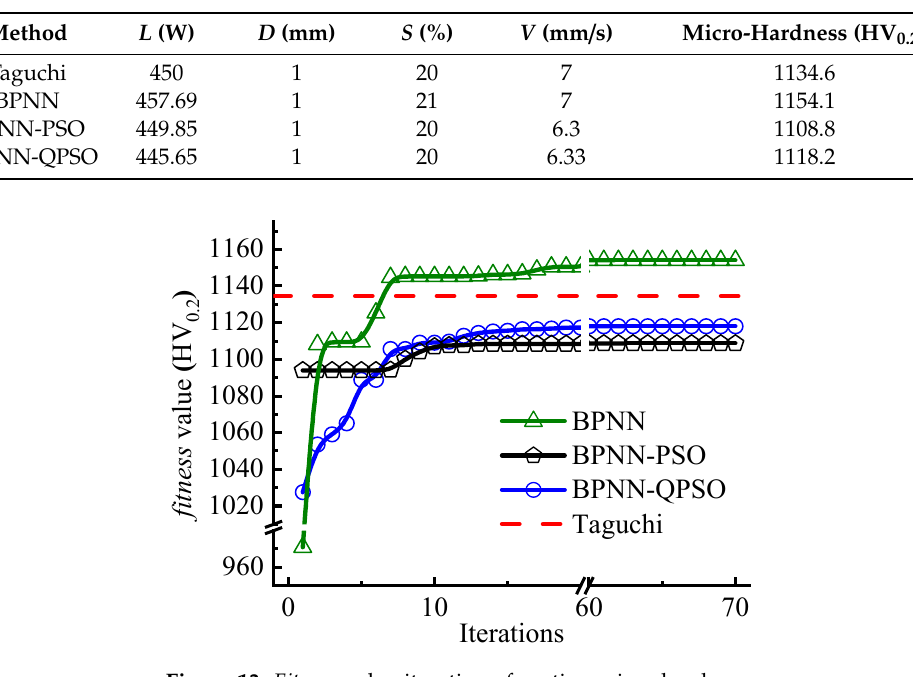
Figure 12. Scatter plot of predicted and experimental micro-hardness of coating: ( a ) BPNN; ( b ) BPNN-PSO; ( c ) BPNN-QPSO.